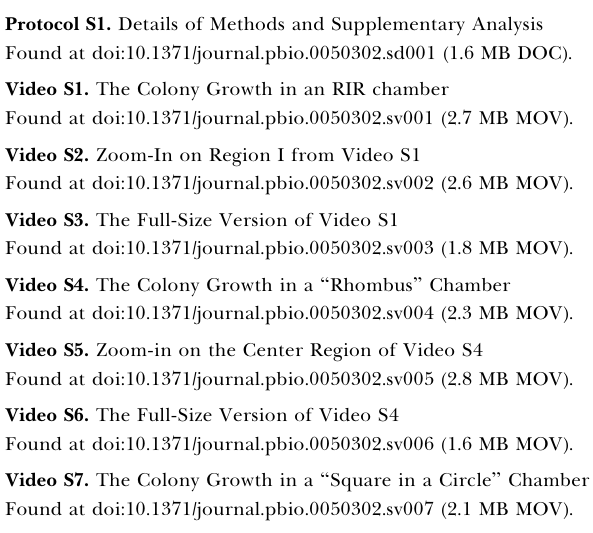
consecutive fluorescence images were manually tracked every 5 min. After 1 h, most of the cells were found at the outer side of the region (closer to the exit of the chamber). A typical trajectory of the cells is indicated by the arrow in the inset. The mean distance traveled by cells from their initial positions is shown as a function of time. The error bars indicate standard deviation. Each plot was fitted to a quadratic curve. The pair-wise difference among the three fits was not significant ( p- values of , 0.05 were considered significant; F - test). The mean velocity of the escaping cells is a measure of the rate of colony growth in the corresponding time interval. (B) The simulated flow stream lines (arrows) and pressure distribution (color-coded) inside the RIR chamber and rhombus chamber filled with a Newtonian fluid with spatially uniform source term, corresponding to a uniform and steady cell proliferation. Found at doi:10.1371/journal.pbio.0050302.sg003 (4.7 MB TIFF). Figure S4. Colony Expansion with No Confining Boundaries (A) Comparison of simulation and experimental results of colony growth with no boundaries. Scale bar is 12 l m. (B) Distributions of cell orientations from the final stage of the simulation and the experiment. Found at doi:10.1371/journal.pbio.0050302.sg004 (3.3 MB TIFF). Figure S5. The Effect of Internal Boundaries in Microchambers on Colony Organization The external boundaries of all chambers are identical and have a shape of a square, whereas the internal boundaries have different shapes. Representative examples and enlarged views of selected regions, a and b, are shown. The internal geometries are (1) rhombus; (2) circle; (3) square; (4) ‘‘ equality sign ’’ ; and (5) no internal boundary. (A) An enlarged view of cell escape points (the exit of chambers). The cells facing the bottom exits (boxes ’a’ in panels 1–4), which are situated in the separation areas between fluxes from the right and left of the exits, are found to be less fluorescent than cell in the surrounding regions. This is likely because cells in the separation area do not arrive from internal regions of the chamber, but rather grow and divide in relative proximity of the exit. In contrast, the fluorescence in the ‘‘ flux ’’ areas reflects the history of exposure of cells to lower glucose concentrations in more internal regions of the chambers. This effect becomes increasingly pronounced from panel 1 to panel 4, as the variations in the shape of the internal boundary facing the exit (from a pointed apex of a rhombus, to a circle, to a square, to a horizontal line on top of two exits) create increasingly wide separation areas. (B) The orientation of the internal boundaries strongly influences the direction of orientation of cells in the colony. Notice that in the case of the ‘‘ equality sign ’’ (panel 4), the horizontal orientation of the internal boundaries imposes horizontal orientation on cells in the middle of the chamber, whereas when no internal boundaries are present (panel 5), the cell orientation is vertical. Scale bars: 50 l m, upper panels; 20 l m, panels (a) and (b). For examples of cell orientations in chambers of other geometries, please consult the Levchenko lab website: http://rd.plos.org/pbio.0050302. Found at doi:10.1371/journal.pbio.0050302.sg005 (7.3 MB TIFF). Protocol S1. Details of Methods and Supplementary Analysis Found at doi:10.1371/journal.pbio.0050302.sd001 (1.6 MB DOC). Video S1. The Colony Growth in an RIR